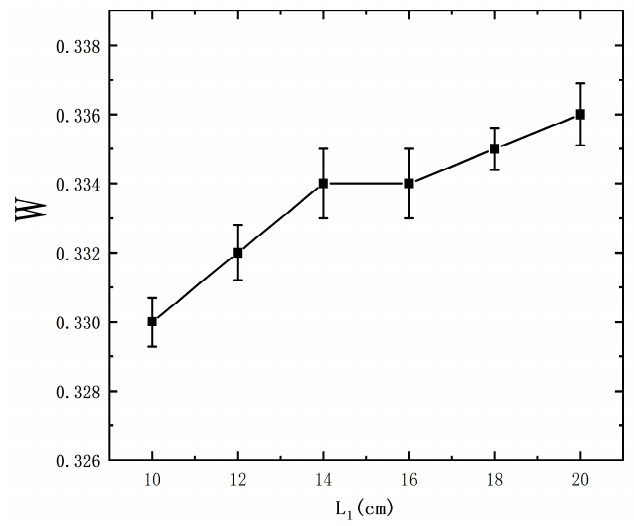
Figure 8. The transmission probability W versus L 1 .